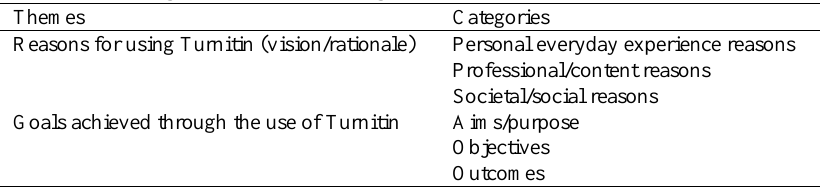
Table 1 Findings (Themes and